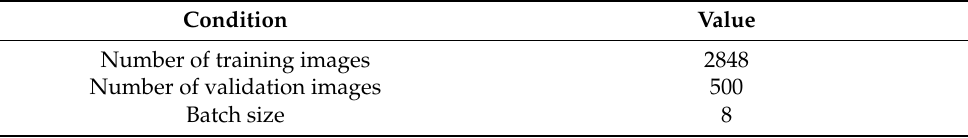
Table 2. Learning conditions for road extraction model.